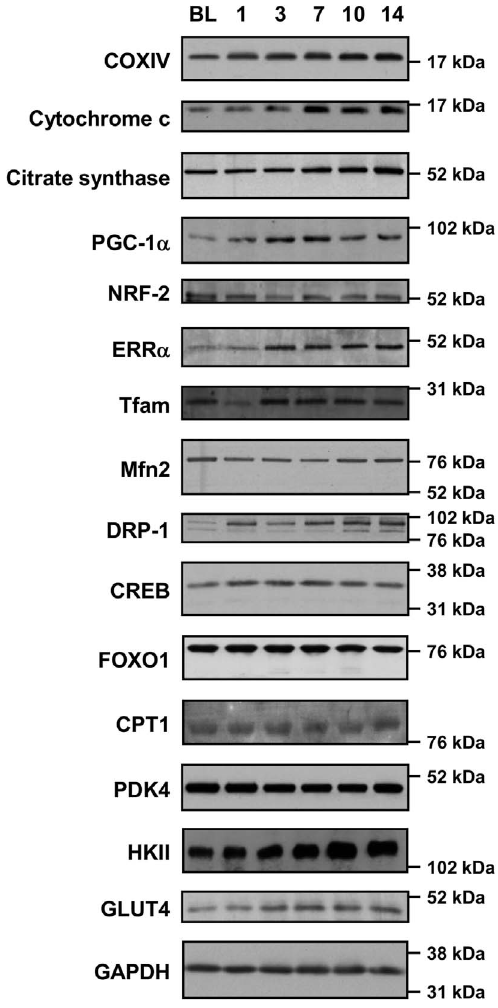
Figure 2. Representative immunoblots for proteins of interest. Protein extracts from skeletal muscle biopsies prior to training (BL, baseline) and after 1, 3, 7, 10 and 14 days of aerobic exercise training were resolved by SDS-PAGE and subjected to immunoblot directed against the protein of interest indicated. Approximate location of molecular weight markers (RPN 800E; GE Healthcare/Amersham) is also indicated. See Table S1 in File S1 for full list of abbreviations.